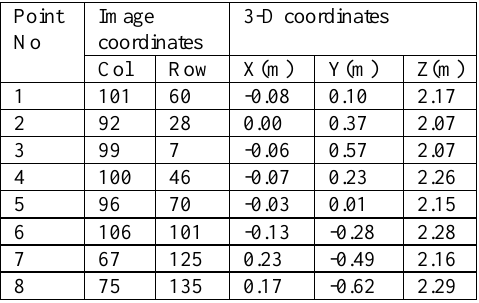
Table 2. Image and 3-D coordinates of the targets in the first image of the sequence